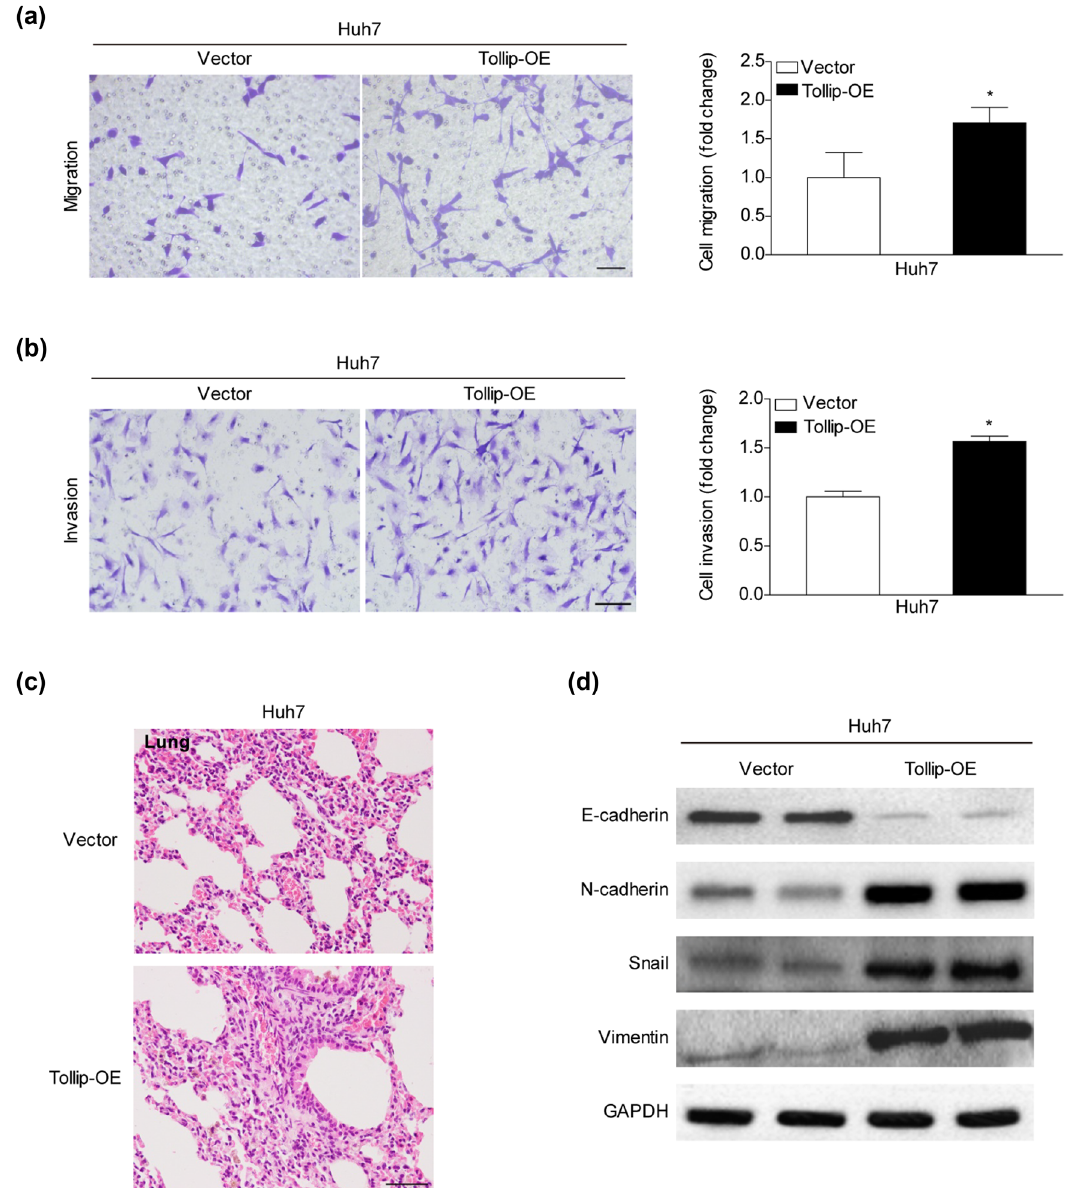
Figure 3: Tollip enhanced migratory, invasive, and metastatic capacities of HCC cells. ( a ) Evaluations of the in fl uence of Tollip - OE on migration activities by transwell migration assays. n = 5 fi elds per experimental group. ( b ) Matrigel invasion assays for testing the e ff ect of Tollip - OE on invasion ability. n = 5 fi elds per experimental group. ( c ) The lung slides from nude mice subjected with Tollip - OE detected by hematoxylin - eosin staining. Scale bar = 50 µm. n = 10 fi elds per experimental group. ( d ) Expressions of EMT - related markers in HCC cell lines infected with overexpression of Tollip by western blot assays. n = 3 independent experiments. * p < 0.05 compared with control